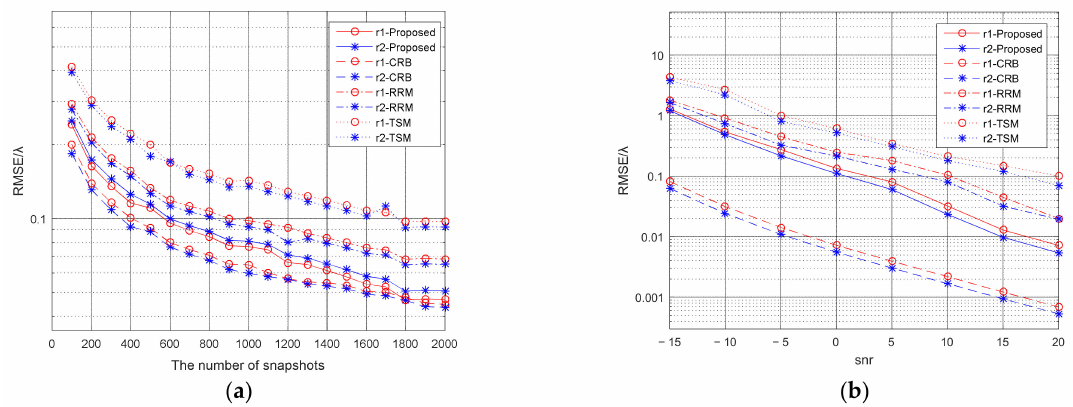
Figure 7. ( a ) The relationship between NS and the RMSE of the ranges estimation; ( b ) The relationship between the SNR and the RMSE of the ranges